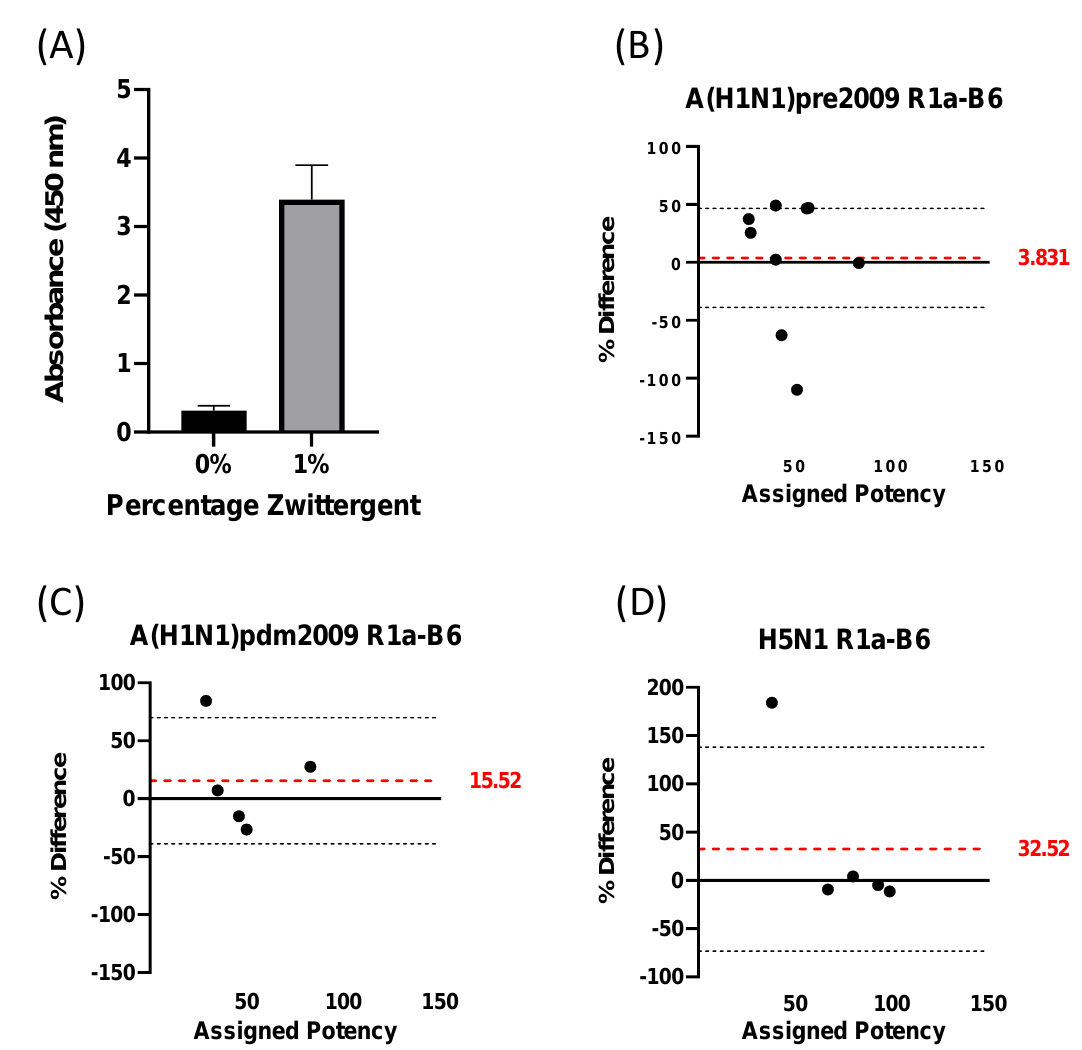
Figure 2. Sandwich ELISA. ( A ) Absorbance signal is shown after pre-treatment of antigen with or without 1% Zwittergent 3–14 detergent. ( B ) Difference plot analysis of results from sandwich ELISA on A(H1N1) antigen reagents from 1976–2007, ( C ) A(H1N1)pdm09 antigen reagents and ( D ) H5 subtype antigen reagents. Assigned potency is in µ g/mL; black dotted lines indicate 95% confidence intervals; red dotted lines indicate average percentage differences.